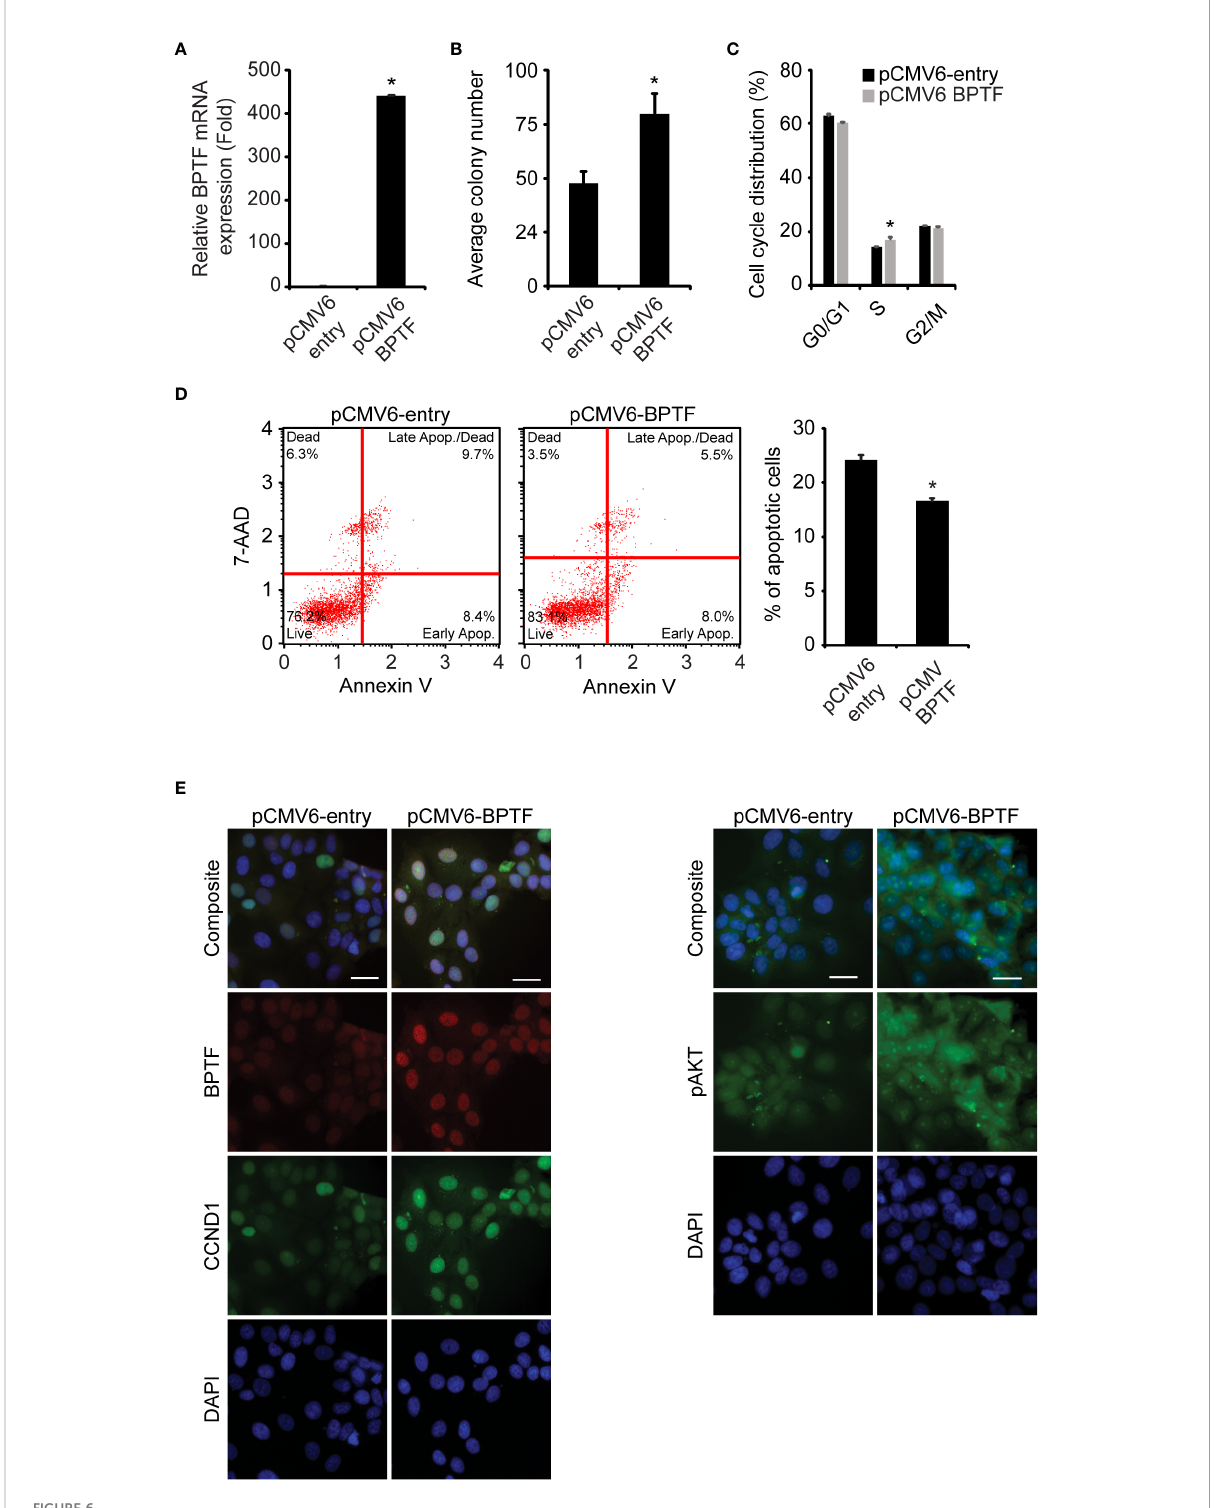
FIGURE 6 Effects of BPTF overexpression on MCF-7 cells. (A) BPTF overexpression in MCF-7 cells. (B) Colony forming capacity of MCF-7 cells after BPTF overexpression. (C) Cell cycle analysis following BPTF overexpression. (D) Analysis of apoptotic rate after BPTF overexpression based on detection of 7-AAD and Annexin V. (E) Quantitative immuno fl uorescence of various proteins following BPTF overexpression. Scale bar 20 m m. *p <